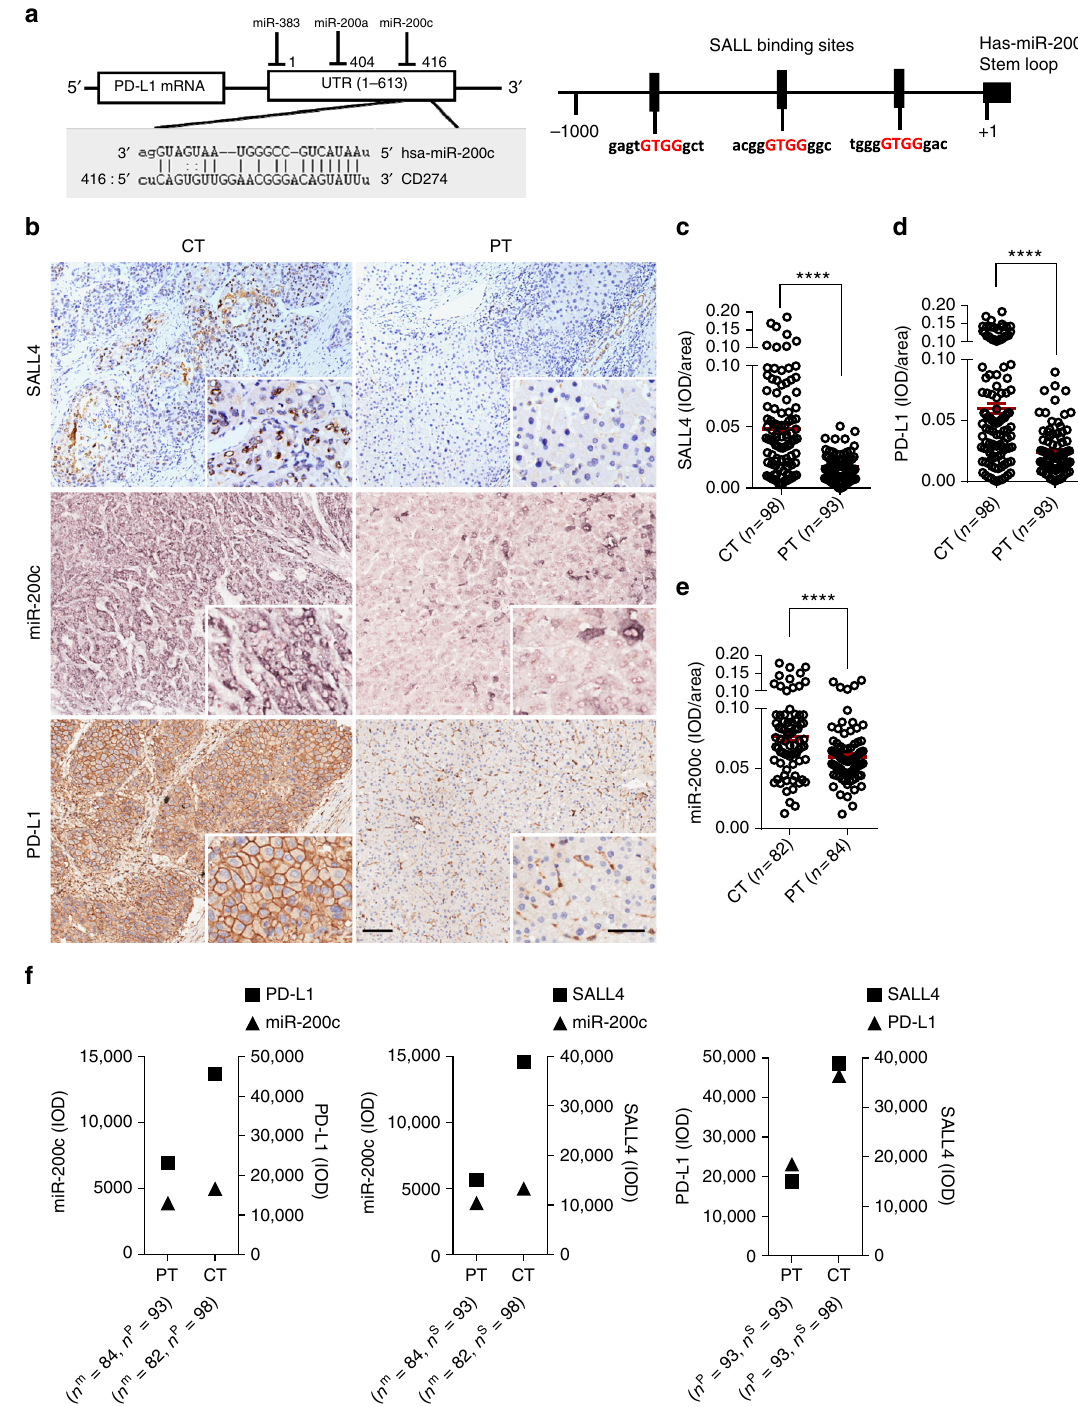
Fig. 1 Expression of SALL4, miR-200c, and PD-L1 in the center tumor regions of HCC. a Predicted microRNA targeting PD-L1 3´-UTR includes miR-200a, miR-200c, and miR-383 (left); the upstream promoter region of the human miR-200c showing putative SALL4-binding sites (right). b Immunostaining of SALL4 and PD-L1 proteins (brown color) and in situ hybridization for hsa-miR-200c (blue purple color) in the center of the tumor (CT) and peritumor (PT) regions of HCC. Original magni fi cations: × 10, × 20; bar = 100 µ m, 50 µ m, respectively. c – e Increased SALL4 ( c , P < 0.0001), PD-L1 ( d , P < 0.0001) and miR-200c expression ( e , P < 0.0001) in CT regions. Cumulative data calculated by two-tailed unpaired Student ’ s t -test. The results are expressed as the mean ± SEM. **** P < 0.0001. f Disparity analysis between miR-200c and PD-L1 (left), miR-200c and SALL4 (middle), PD-L1 and SALL4 (right) in CT and PT regions. n P , number of patients with PD-L1; n m , number of patients with miR-200c; n S , number of patients with